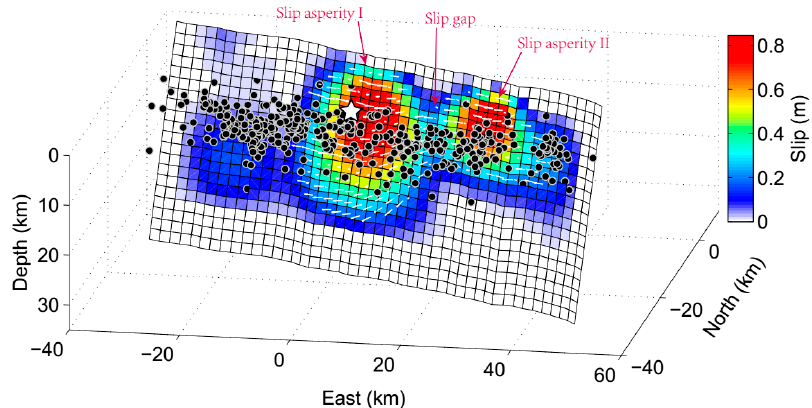
Figure 6. Three-dimensional diagram of the optimal slip model inverted from InSAR data. The black dots are the relocated aftershocks [1]. The epicenter is marked by a white star for clarity. Two asperities ruptured by the earthquake are marked by slip asperity I and II, respectively. The small slip area between the two asperities is marked by the ‘slip gap’. White arrows on the fault plane denote the slip directions of fault patches.